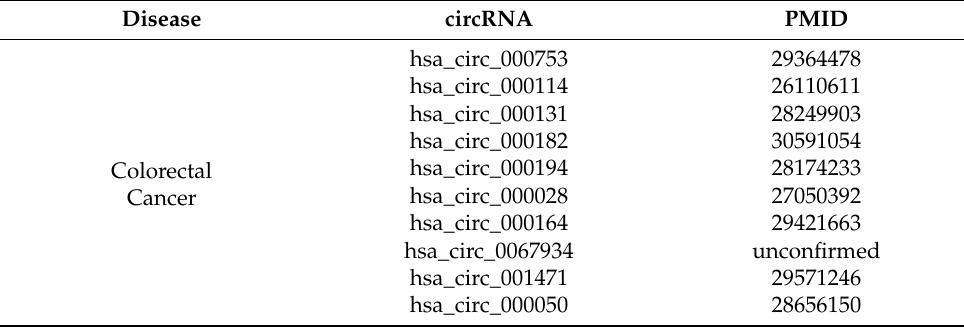
Table 8. The top 10 colorectal cancer-related candidate